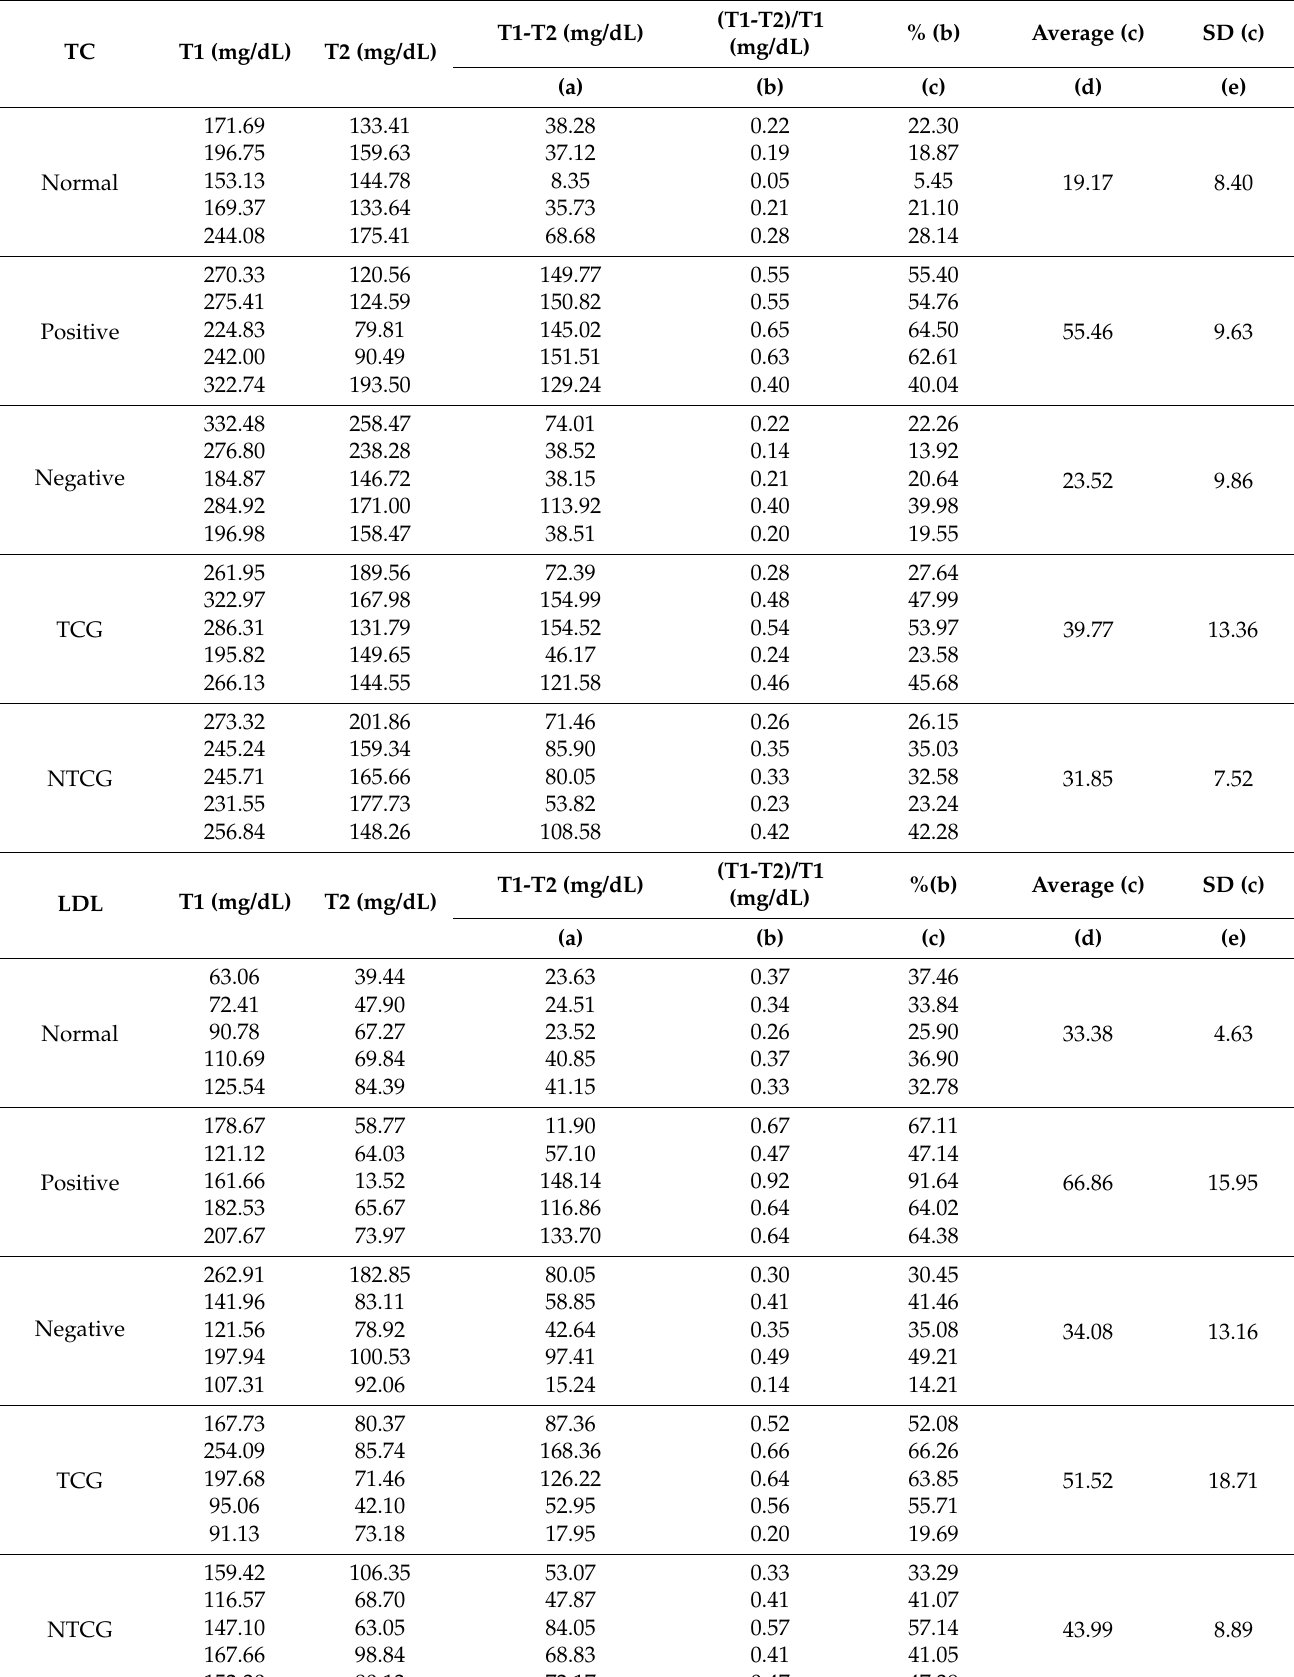
Table 6. Result of TC ( a ) and LDL ( b ) during